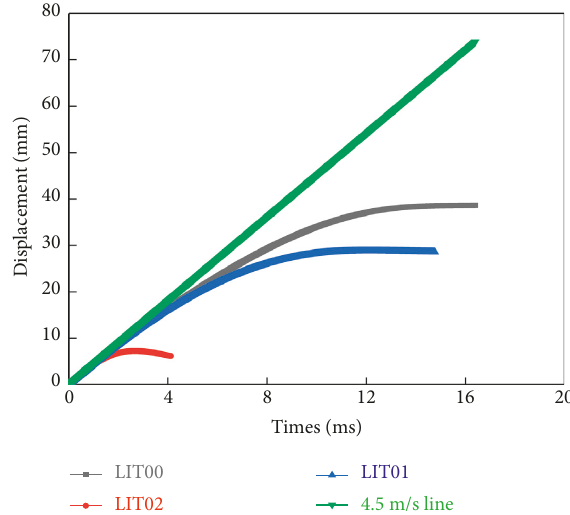
Figure 10: Compression amount time history